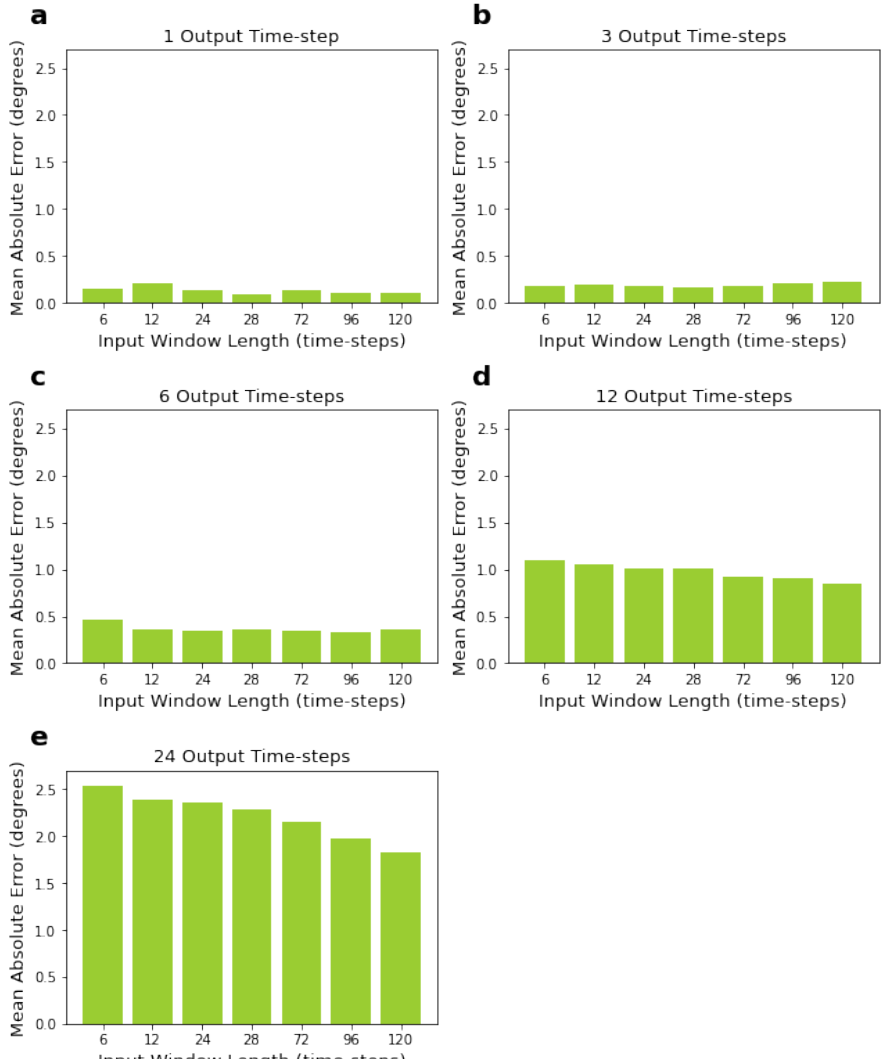
Figure 4. Performance of LSTM, measured by MAE, for varying input and output window sizes. Input sizes range from 6 to 120 time-steps, corresponding to 200 to 1000 ms. Output sizes range from 1 to 24 time-steps, corresponding to 8.33 to 200 ms. Sub-figures ( a – e ) correspond to networks with 1, 3, 6, 12, and 24 output time-steps,